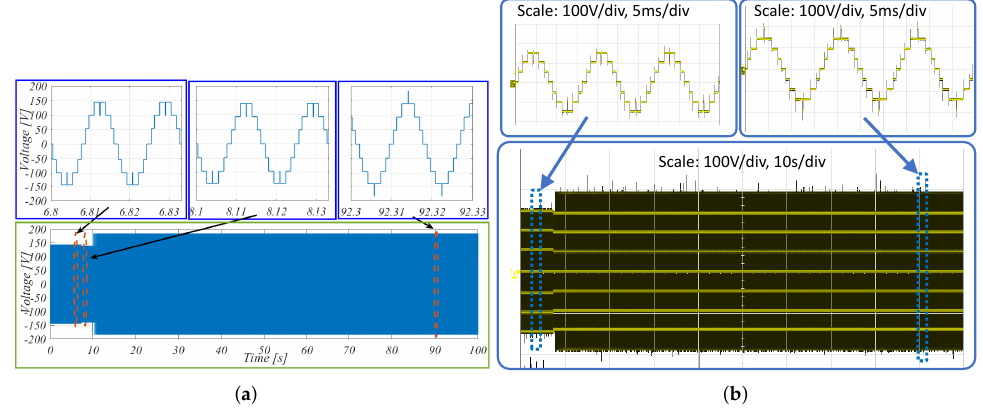
Figure 12. ( a ) Simulations of E 1 disturbance, ( b ) Experimental result of E 1